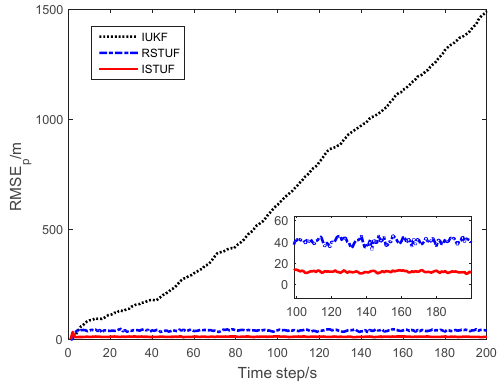
Figure 5. Comparison of the trajectories.